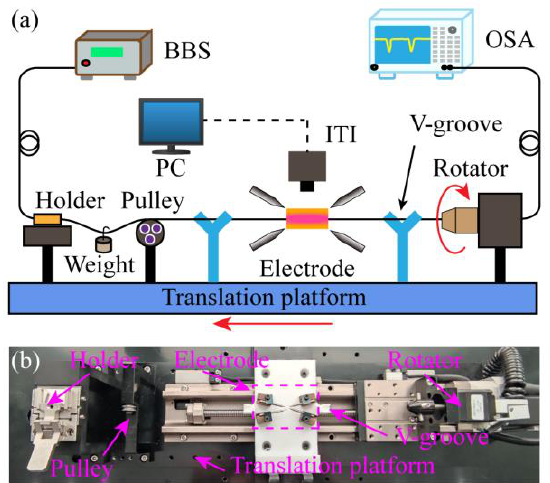
Figure 6. ( a ) The schematic diagram of the improved arc-discharge heating system. ( b ) The photo- graph of the four-electrode arc-discharge heating system.